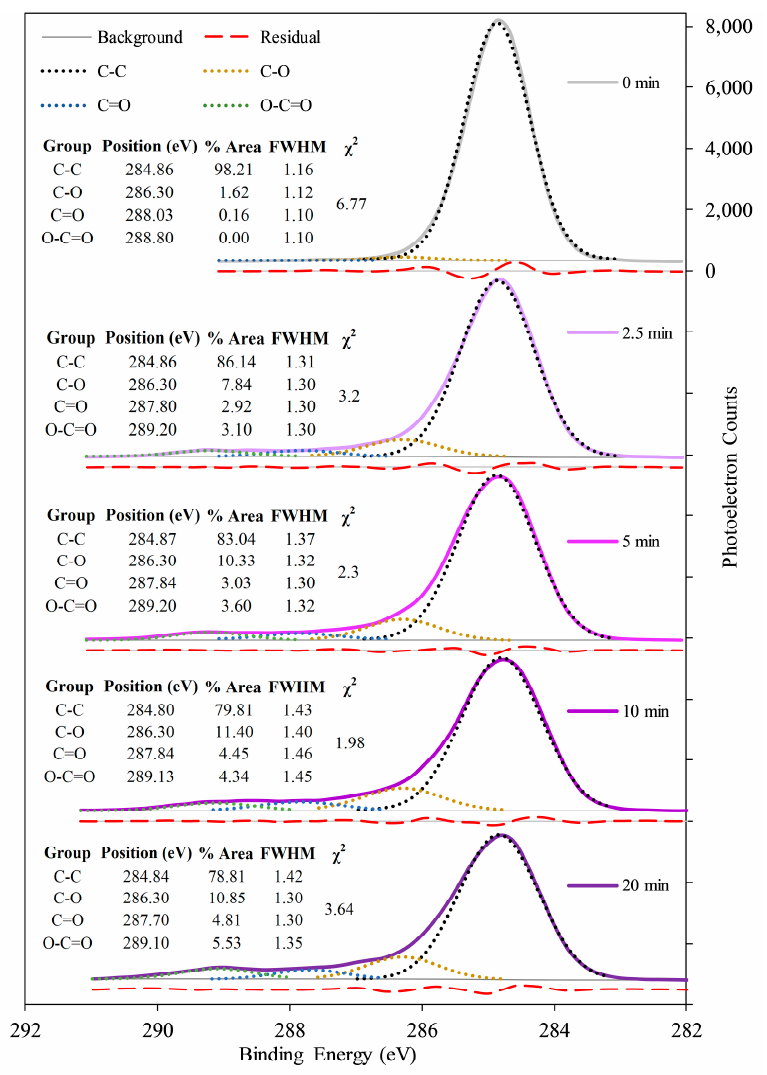
Figure 3. Representative XPS high-resolution scans demonstrate increasing abundance of oxygen-containing functional groups with increasing plasma treatment time. Spectra are intentionally offset from each other along the vertical axis.